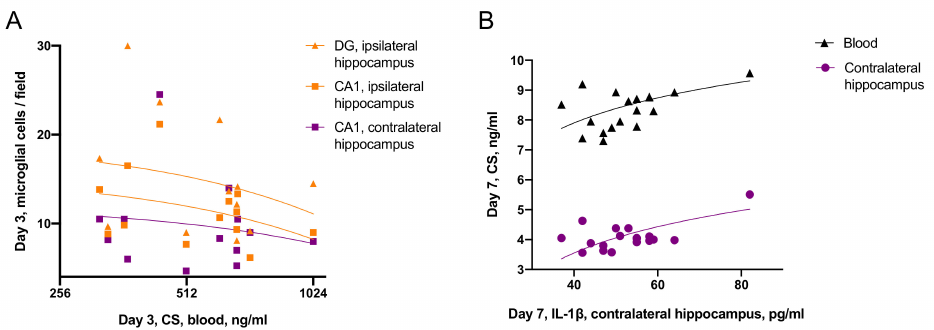
Figure 5. Time-dependent associations of CS and distant hippocampal damage. ( A )—CS negatively correlates with microglial activation on day 3 after TBI (n = 7). ( B )—CS positively correlates with IL-1 β in the contralateral hippocampus on day 7 after TBI (n =